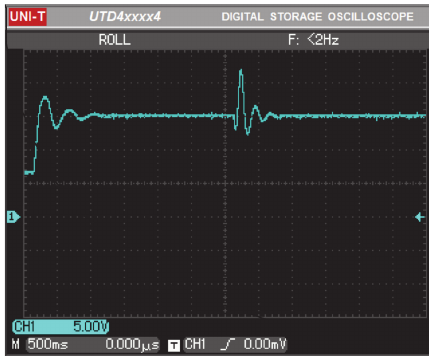
Figure 9: Experimental results: oscilloscope response to the output voltage V 𝑜 (𝑡) of the KAO controller (56).